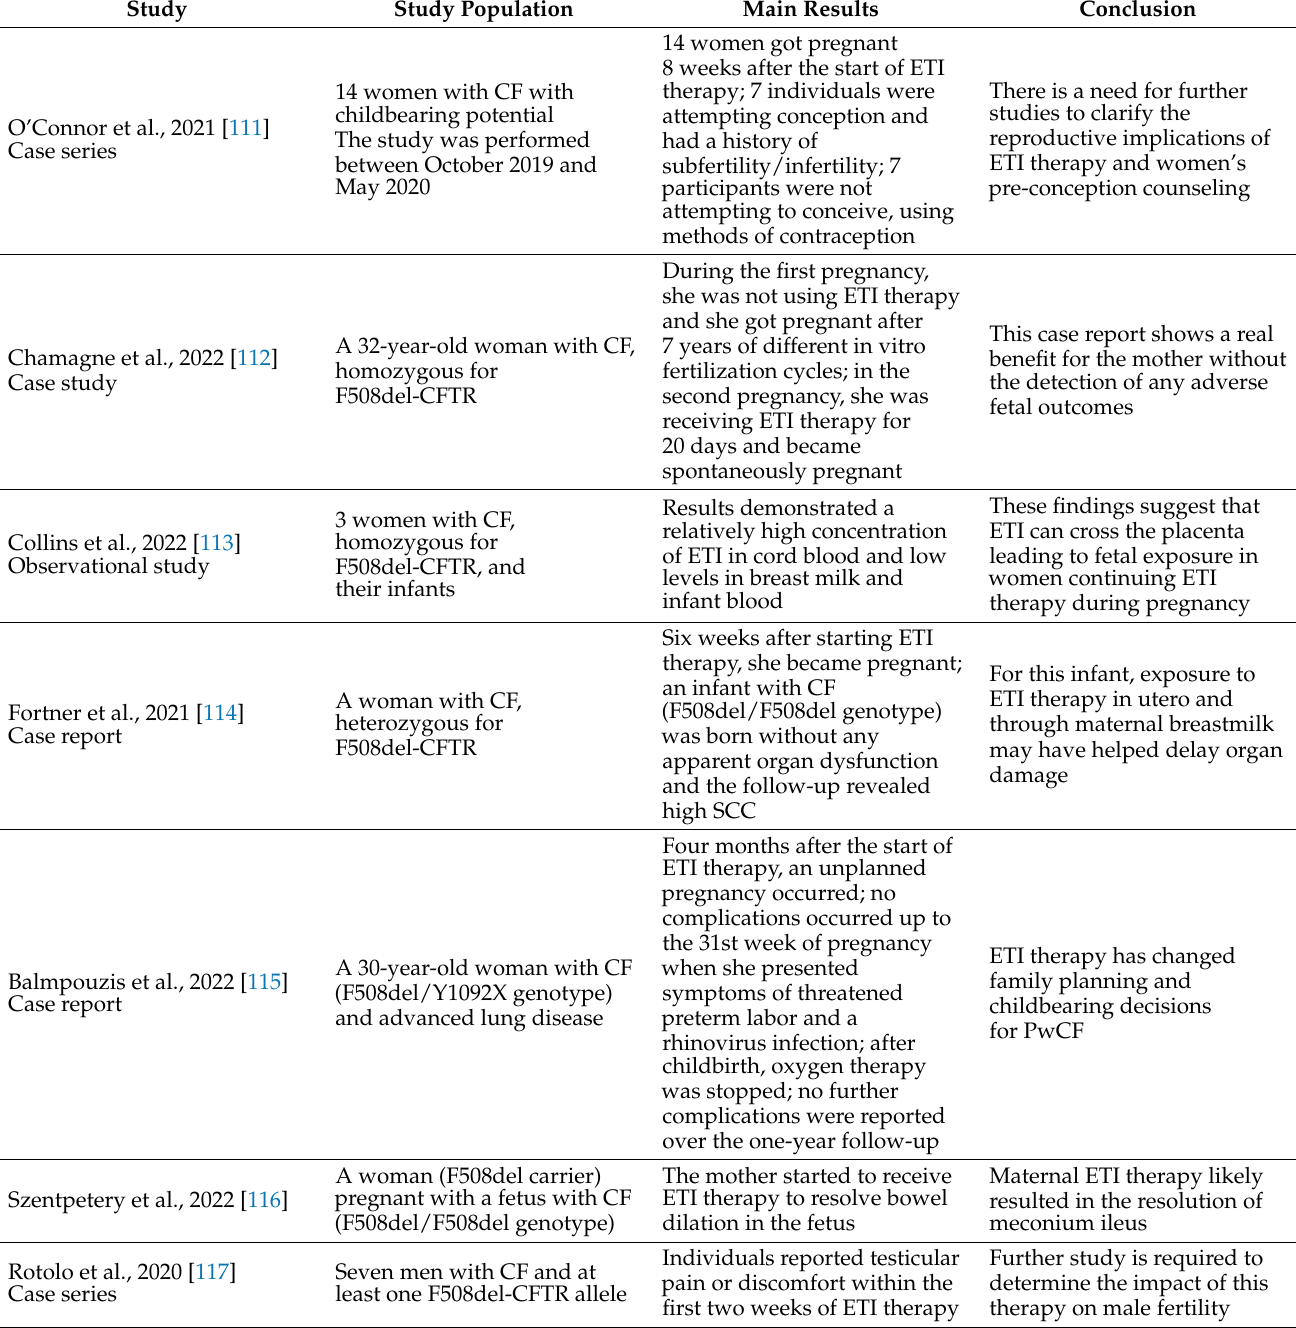
Table 7. Clinical studies assessing the effects of ETI therapy on fertility and pregnancy in